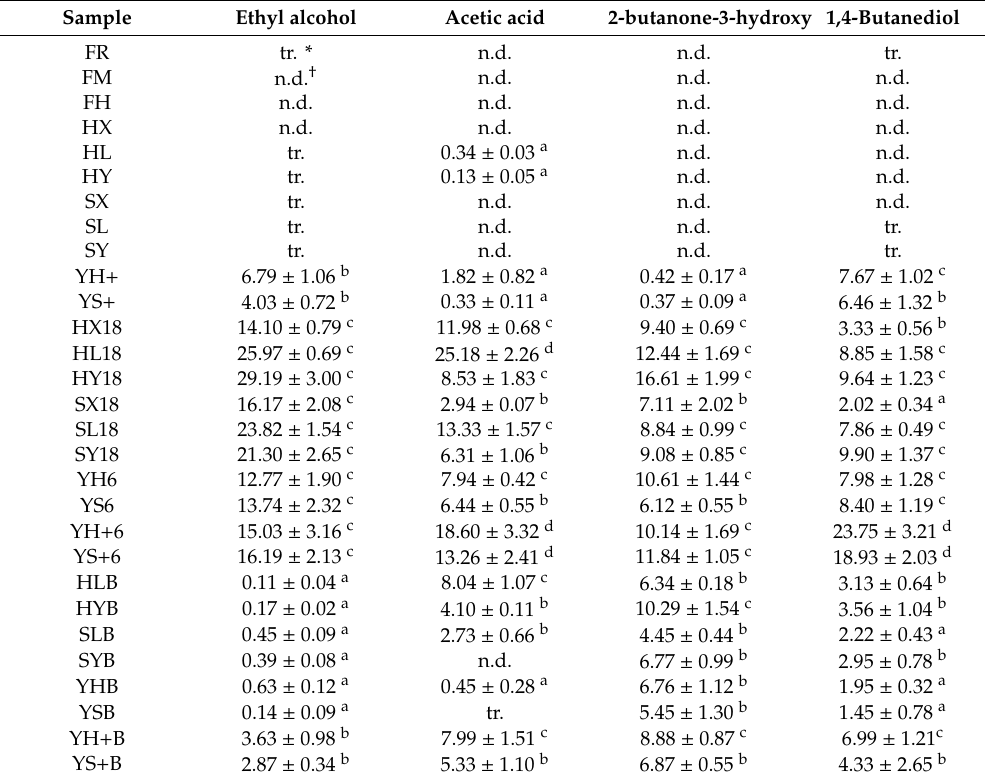
Table 3. Quantification (mg / kg of fermented matrix) of the main fermentation